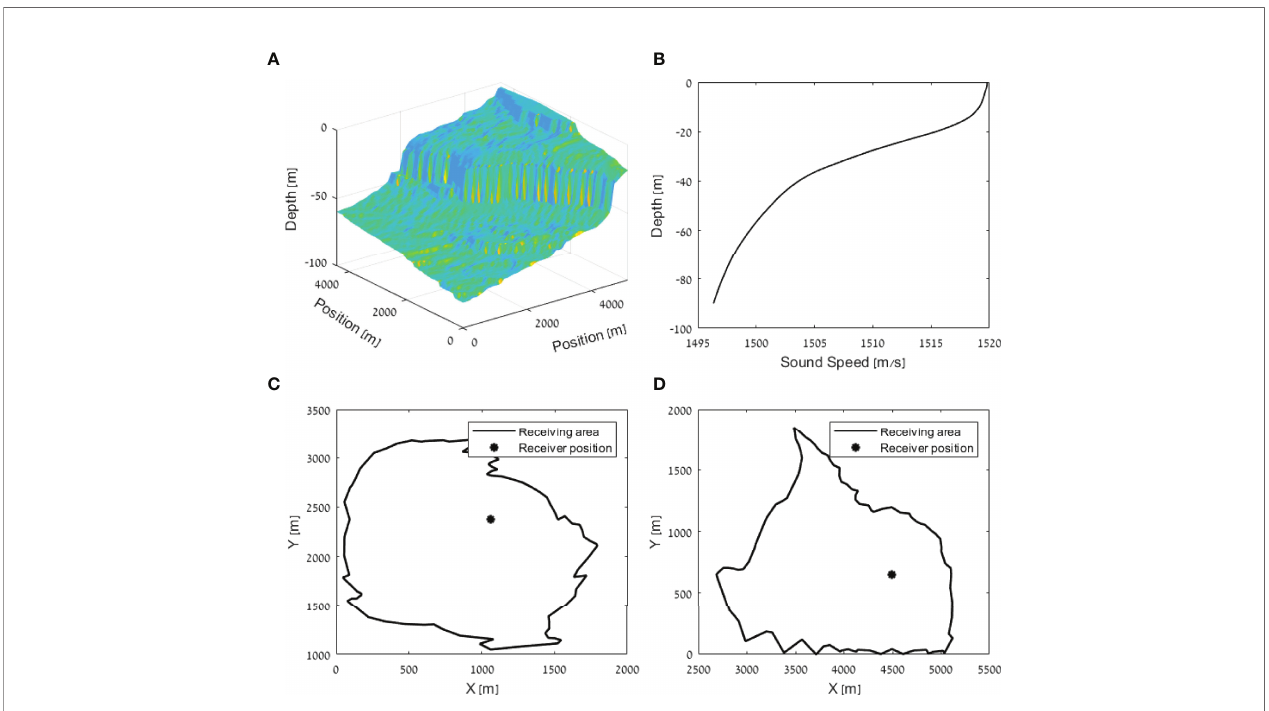
FIGURE 3 | Environmental condition of shallow water close to San Diego Bay. (A) Bathymetry and (B) the sound velocity pro fi le. The impact on the expected detection area of a single receiver is shown in (C) for a receiver positioned at (1000, 2400, -10) and in (D) for a receiver positioned at (4500, 750,